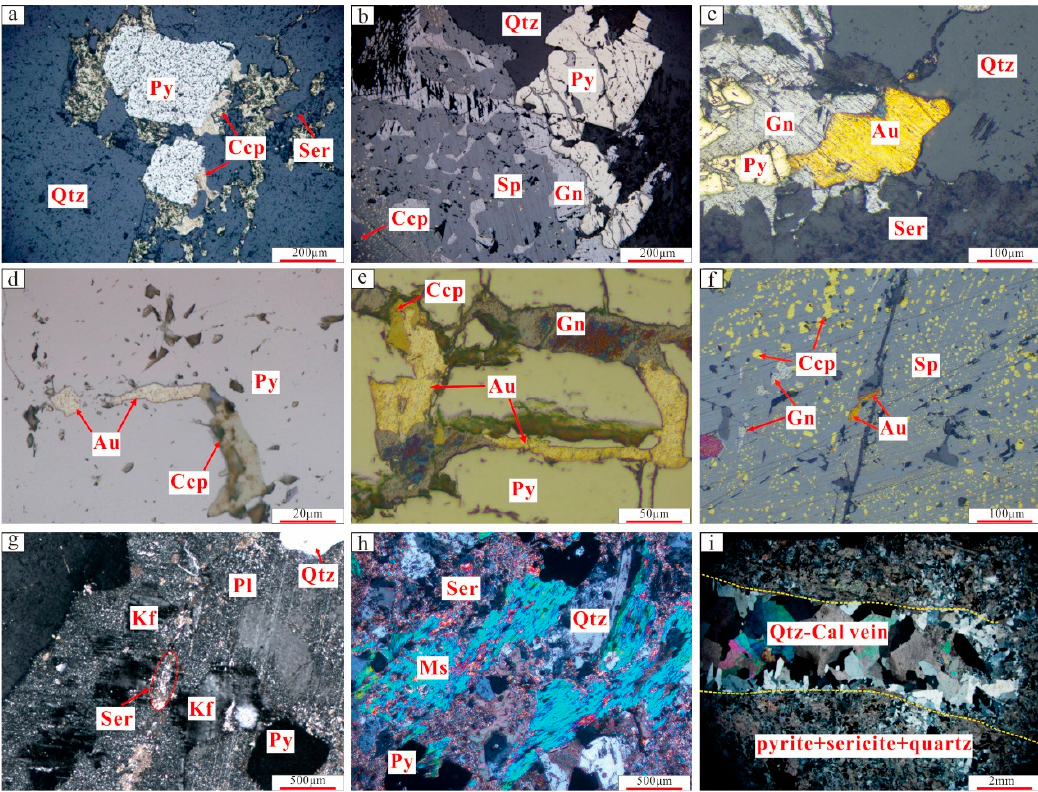
Figure 5. Photomicrographs showing the mineral assemblages of ores, the occurrence of gold (Figure 5a–f), and the alteration (Figure 5g–i) marking different stages in the Liyuan gold deposit. ( a ) Early-stage pyrite cemented by middle-stage chalcopyrite; ( b ) middle-stage galena and sphalerite replacing early-stage pyrite; ( c ) pyrite replaced by galena and coarse-grained gold occurring between quartz, pyrite, and galena; ( d ) and ( f ) gold and chalcopyrite occurring as inclusions in pyrite and sphalerite crystals, suggesting a close relationship; ( e ) gold occurring in the microfissures of pyrite; ( g ) K-feldspathization and sericitization of plagioclase in the early stage; ( h ) pyrite + sericite + silica alteration; and ( i ) late-stage quartz and calcite vein. Mineral abbreviations: Py, pyrite; Gn, galena; Ccp, chalcopyrite; Sp, sphalerite; Au, gold; Qtz, quartz; Ser, sericite; Ms, muscovite; Kf, K-feldspar; and Cal, calcite.